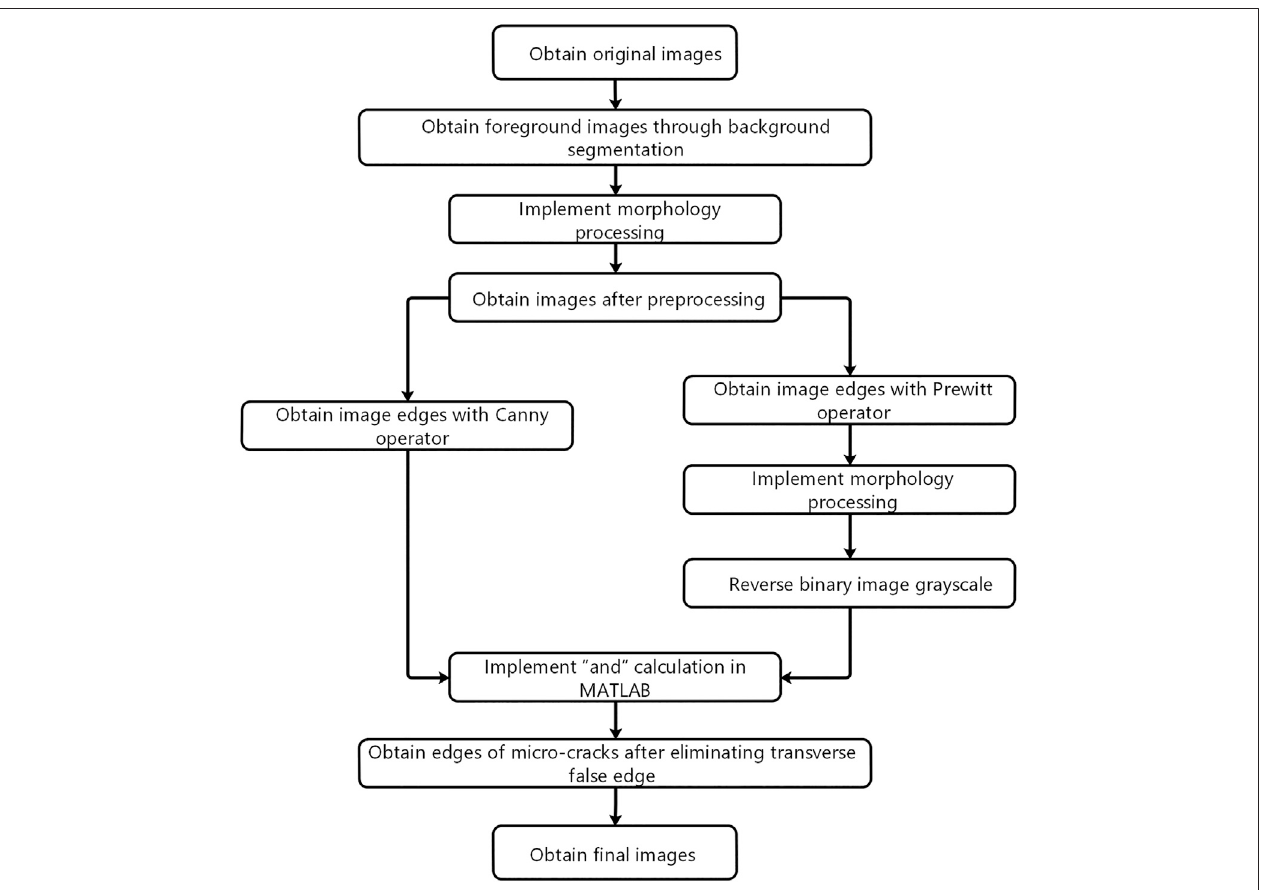
FIGURE 5 | Flowchart of the algorithm proposed in the